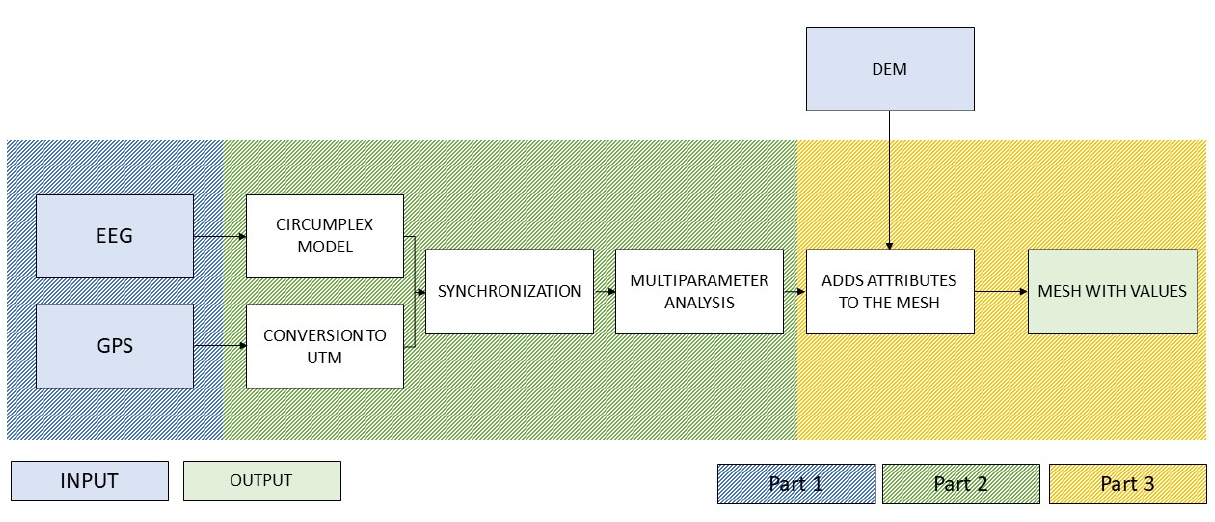
Figure 3 - Logical scheme of the